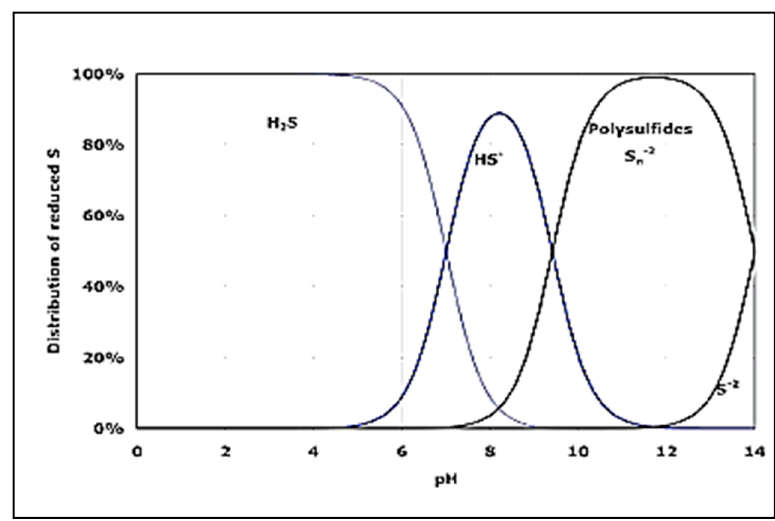
Figure 2. Distribution of different forms of sulfide ions depending on the pH value [28].